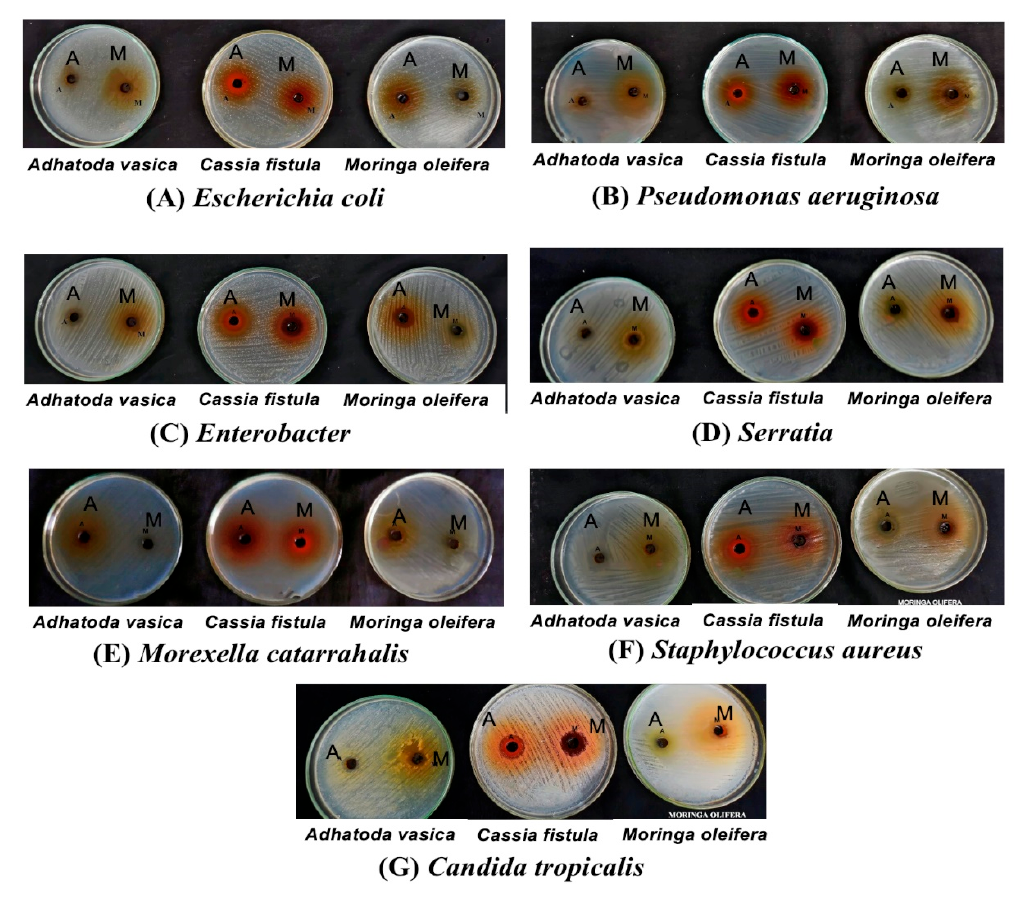
Figure 2. The antimicrobial activities of the plant extracts. ( A – G ): Antimicrobial activity of Adhatoda vasica, Cassia fistula , and Moringa oleifera against different isolated pathogens (A: Acetone, M: Methanol). 3.4. MIC Values of the Plant Extract, Viz. Moringa Oleifera, Adhatoda Vasica, and Cassia Fistula, against